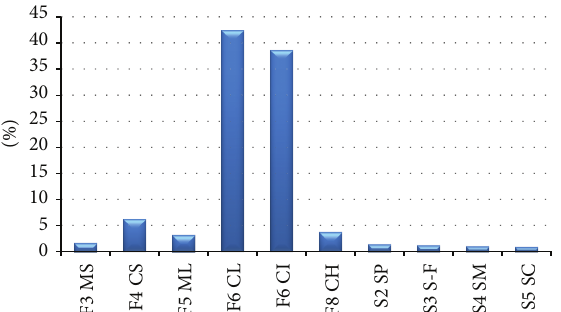
Figure 5: Number of studied samples in the individual foundation soil classes.